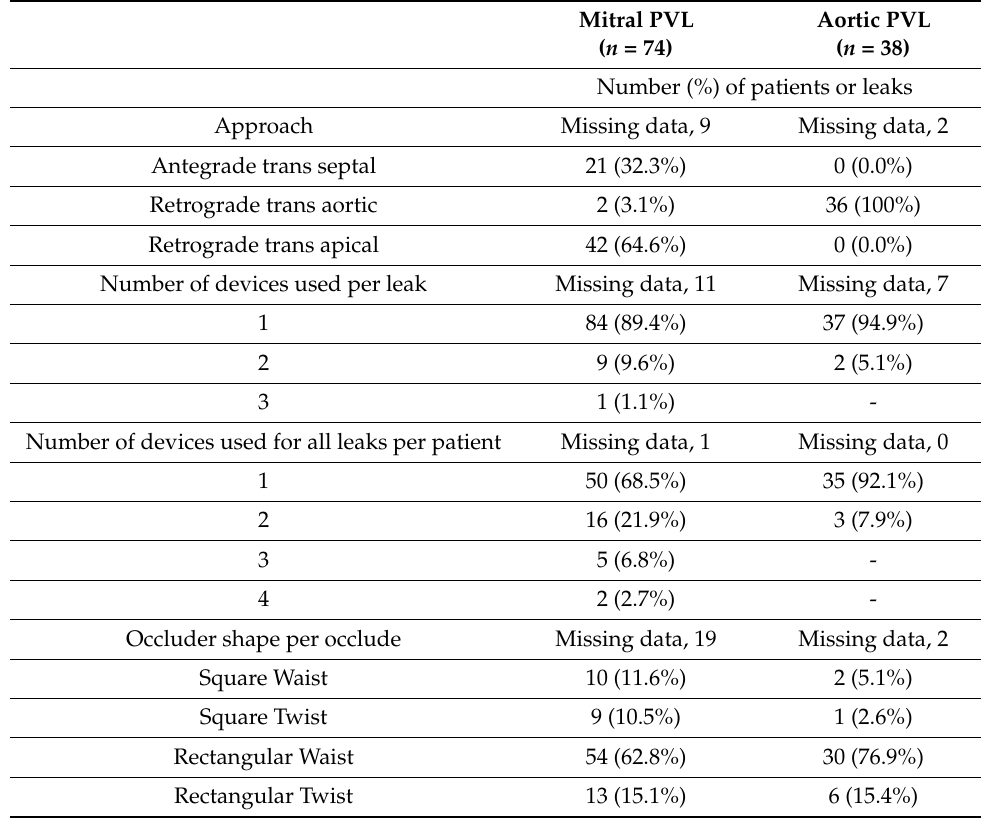
Table 2. Procedural characteristics in the full analysis set